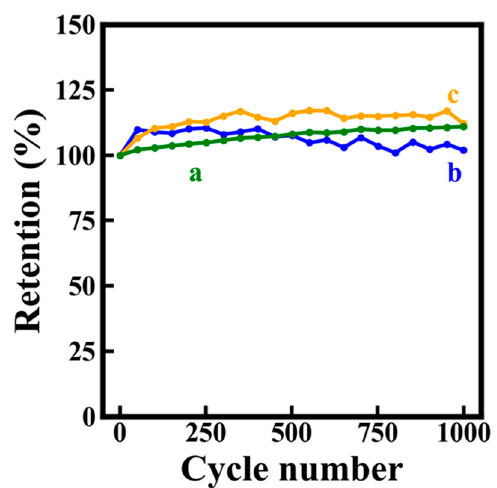
Figure 7. Galvanostatic charge–discharge (GCD) data for electrodes prepared ( A ) without dispersant, ( B ) in the presence of chlorogenic and ( C ) in the presence of 3,4,5-trihydroxybenzamide at current densities of (a) 3, (b) 5, (c) 7 and (d) 10 mA cm -2 , ( D ) capacitances calculated from the GCD data for electrodes prepared (a) without dispersant, (b) in the presence of chlorogenic and (c) in the presence of 3,4,5-trihydroxybenzamide versus current density.